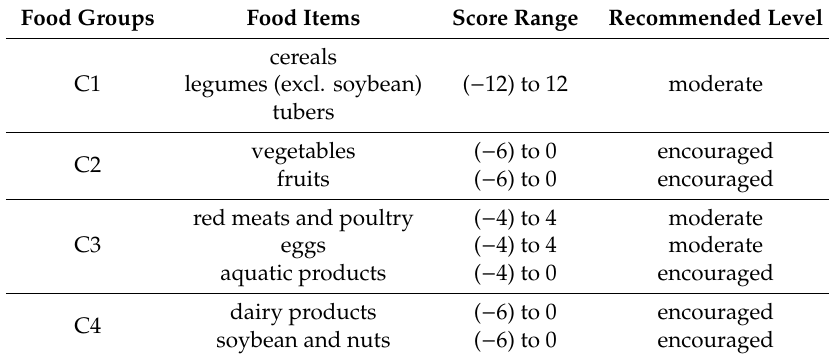
Table 1. The score range for each food item in the NDBI scoring system. Each food is recommended at moderate level or encouraged level. Moderate level considers both inadequate and excessive intake, so could be positive or negative, while encouraged level only considers inadequate intake. The scores are set according to DBI_16 (Diet Balance Index, 2016 version). Food Groups Food Items Score Range Recommended Level cereals C1 ( − 12) to 12 moderatelegumes (excl. soybean) tubers vegetables ( − 6) to 0 encouraged C2 fruits ( − 6) to 0 encouraged red meats and poultry ( − 4) to 4 moderate C3 eggs ( − 4) to 4 moderate aquatic products ( − 4) to 0 encouraged dairy products ( − 6) to 0 encouraged C4 soybean and nuts ( − 6) to 0